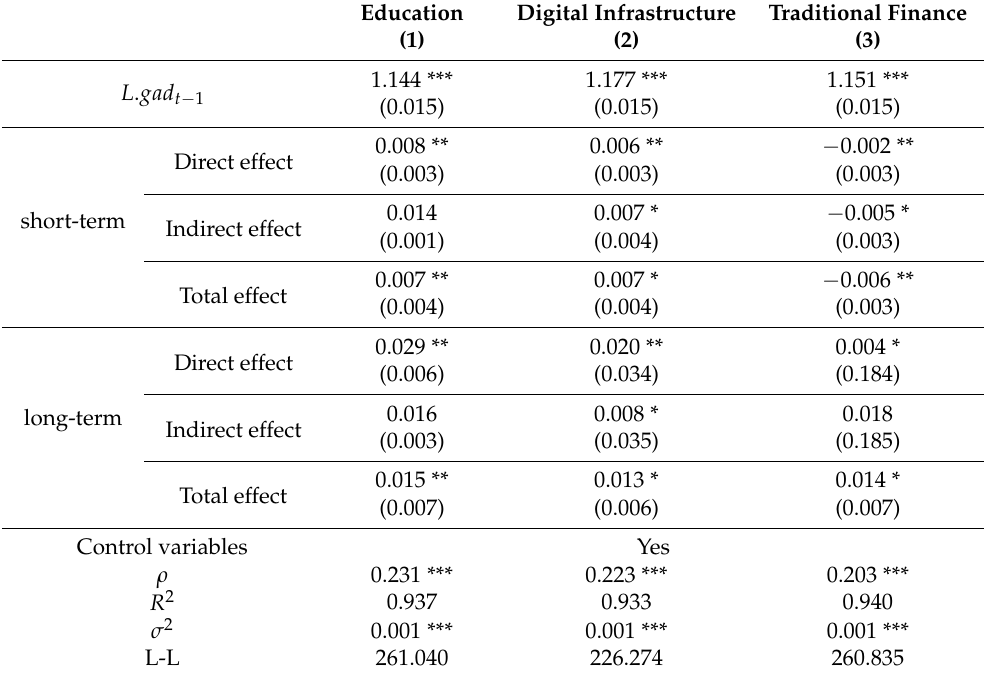
Table 6. The results of the moderating effect